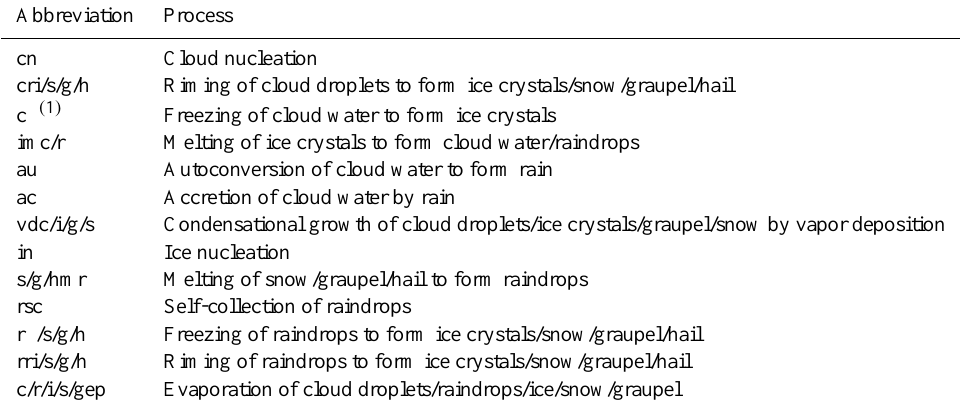
Table A1. Abbreviations and descriptions for individual microphysical